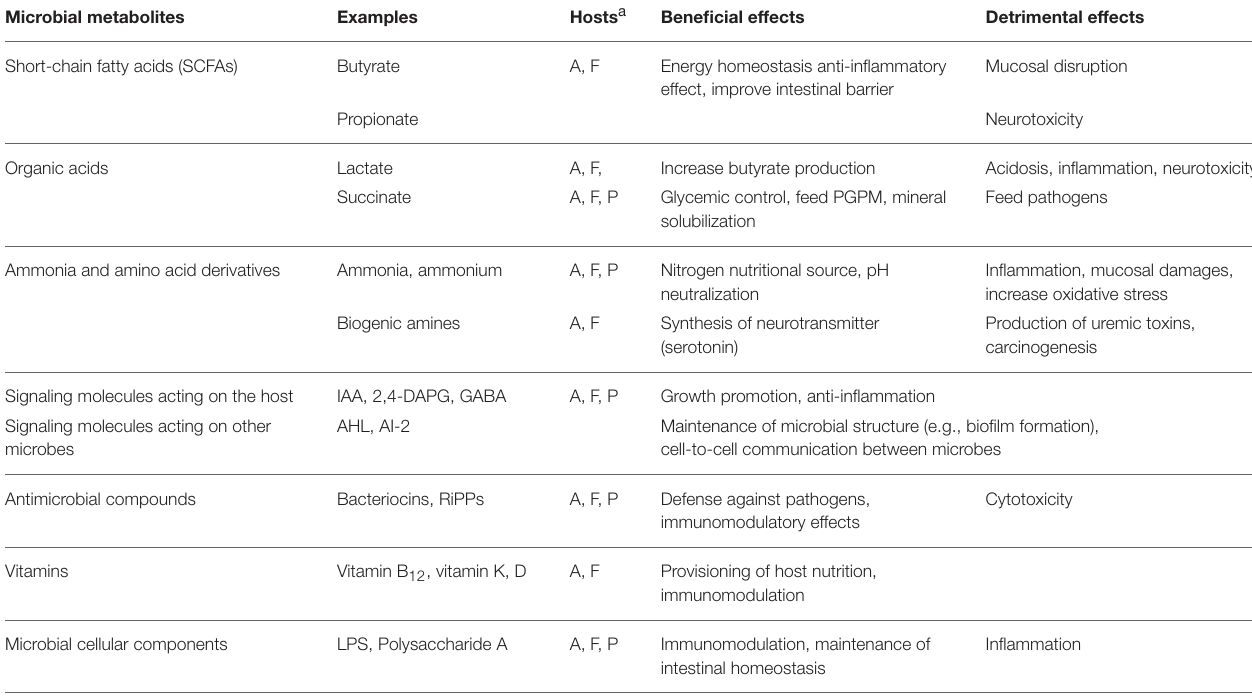
TABLE 1 | Important microbial metabolites and their effects on host animals, fish, and